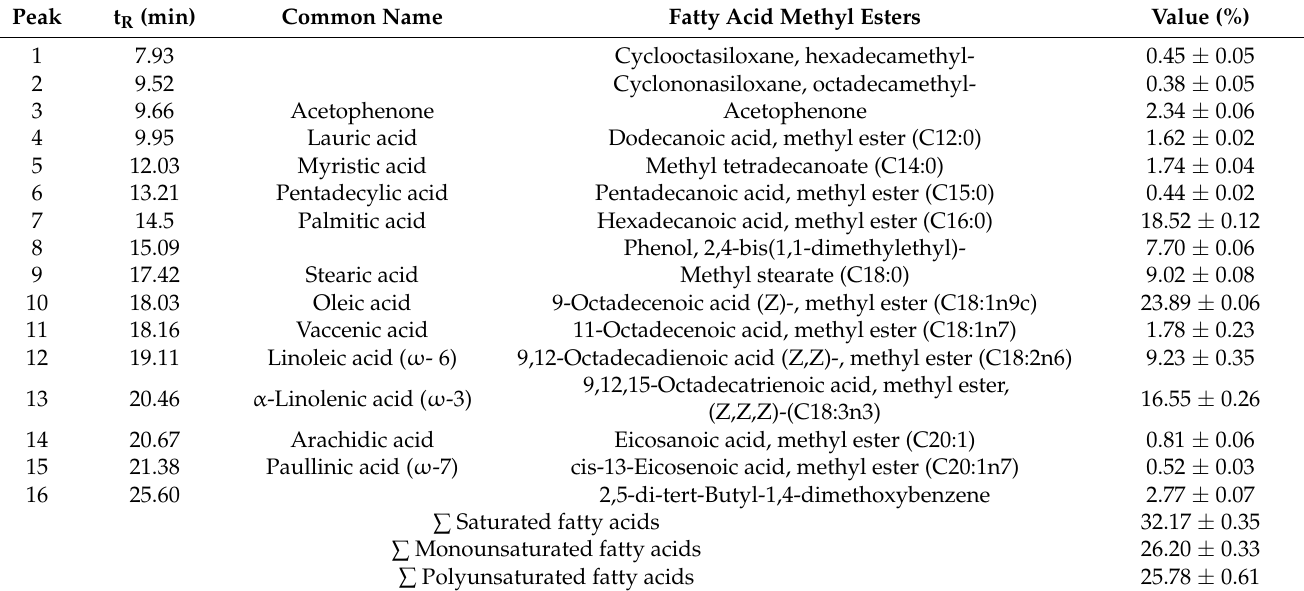
Table 2. Fatty acid methyl ester compositions of wood apple ( Limonia acidissima L.) fruit pulp oil 1 .